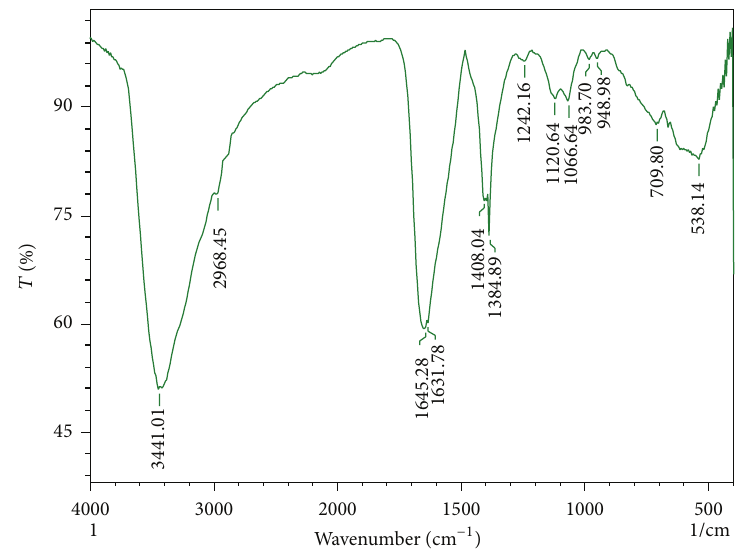
Figure 3: FTIR spectrum of fruit extract of A. marmelos treated with 1mM AgNO 3 .